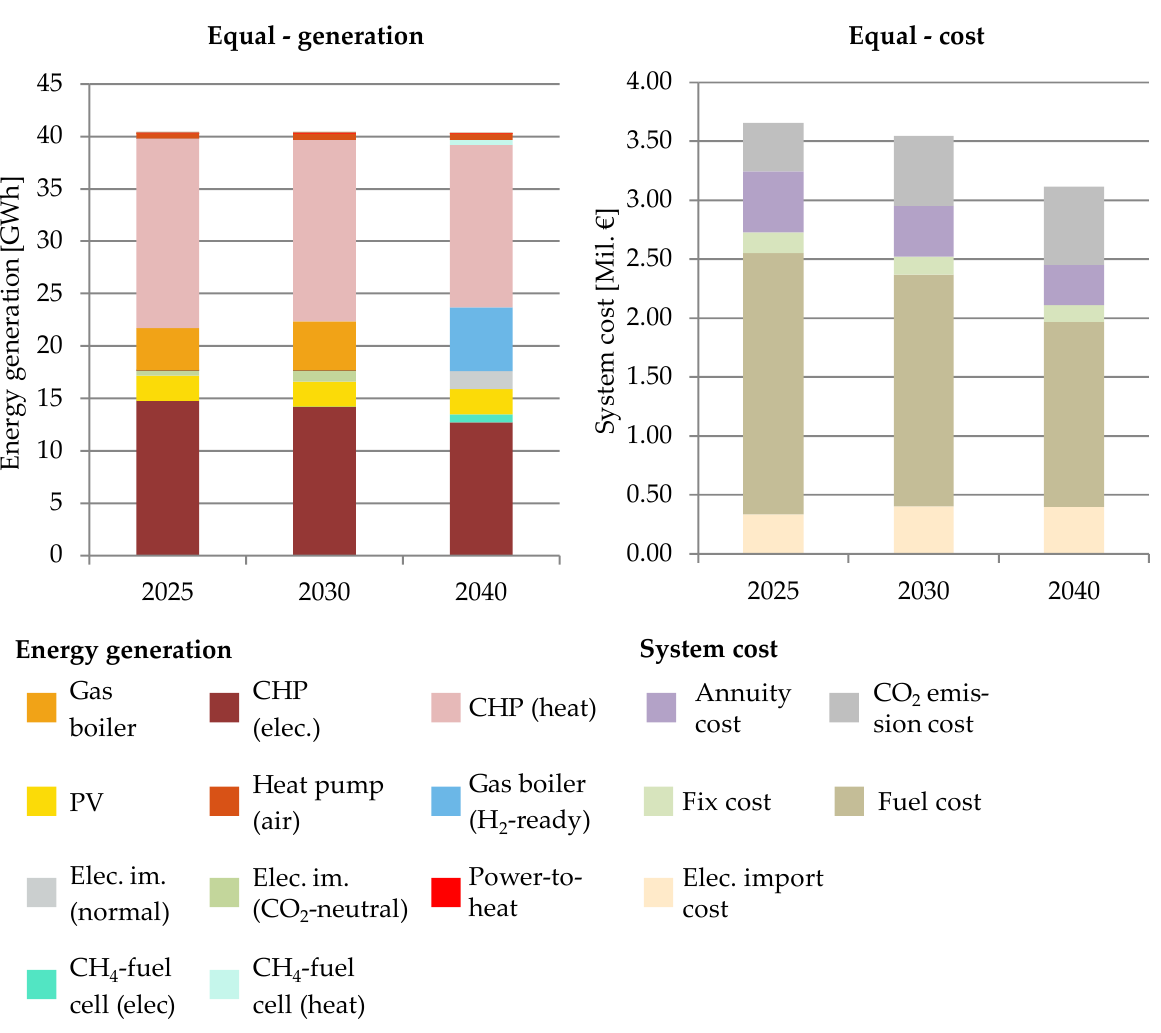
Figure 13. Energy generation and costs for the equal scenario (myopic, without CCS). The significantly lower STCD of the low and medium scenarios, once CCS is excluded, can be best explained by looking at the cost structure of the high and “planned for high but low manifests” scenario for both settings (with and without CCS, Figure 14). The cost structure shows that the cost of the “planned for high but low manifests” scenario does not change, since the installed technologies do not change either (see Figures 9 and 11). The cost of the high scenario increases due to the missing CCS technology and the switch to hydrogen. Therefore, the STCD, which is a relative measure, decreases for the low and medium scenarios once CCS is